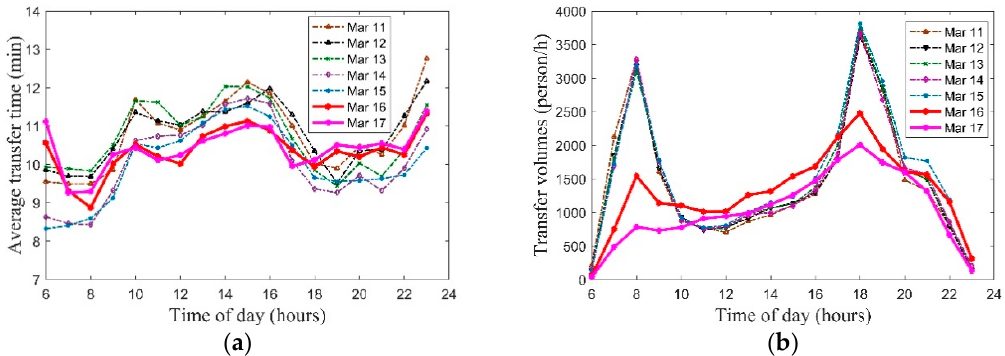
Figure 1. Transfers distribution at different times of day. ( a ) Transfer time distribution. ( b ) Transfer volume distribution.